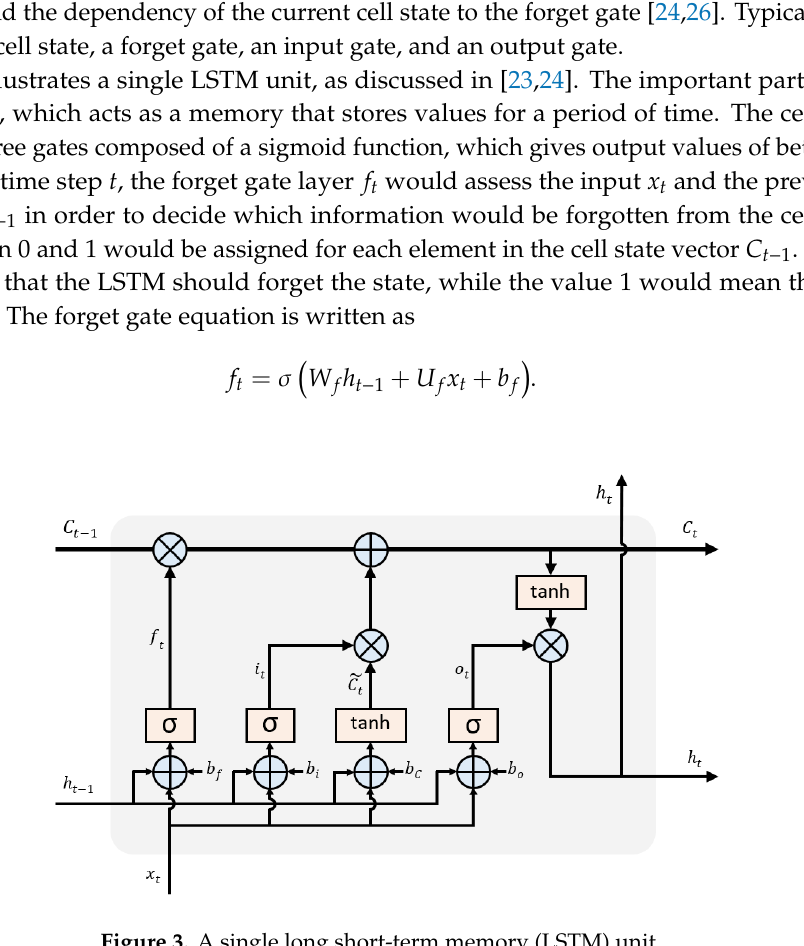
Figure 3. A single long short-term memory (LSTM) unit.